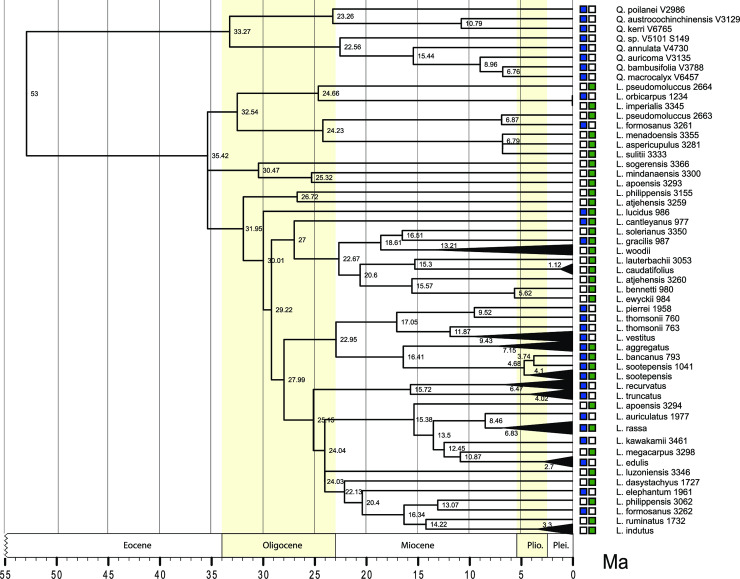
Dated tree based on the reconstructed MIGseq loci (Penalized likelihood).Nodes ages (in Ma) are indicated as well as the geographic range in the 2-zones configuration (tips of the branches, colors according to those in Fig 1).